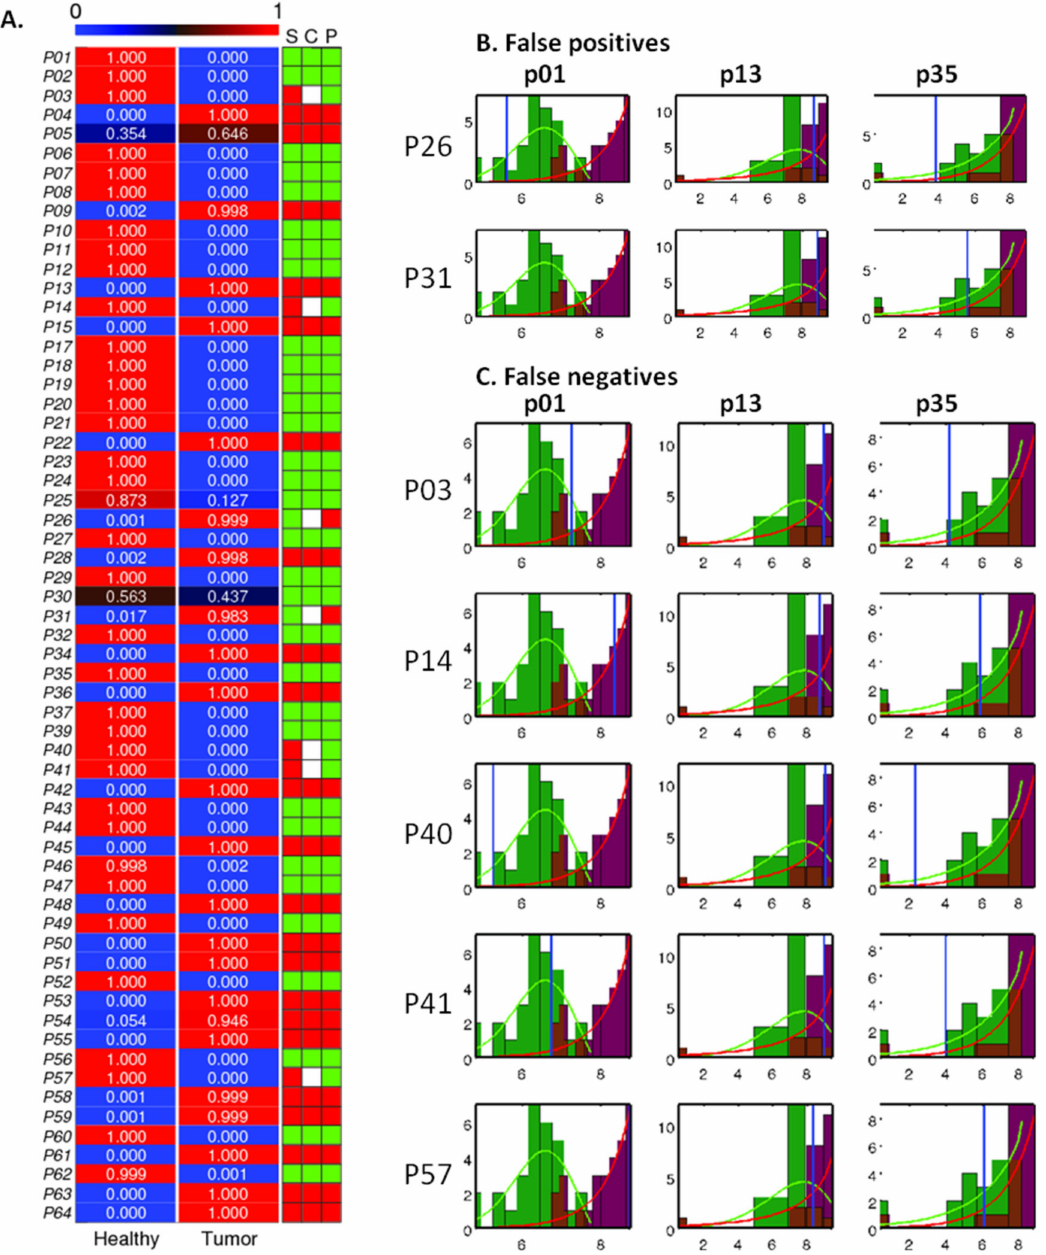
Figure 4. Predictions of the best combination of probes (p1, p13 and p35) on the prospective dataset of 61 patients. ( A ) Heatmap of the probabilities of each sample to be predicted as healthy or tumor. The table to the right marks: S, real status of the sample; P, prediction of the status; and C, the comparison between them. Healthy in green, tumor in red, and mismatch between real status and prediction in white. ( B , C ) Histograms and empirical distribution functions of the probes in healthy (green) and tumor (red) samples of the false positive ( B ) patient samples (P26 and P31) and false negative ( C ) patient samples (P03, P14, P40, P41 and P57). The empirical distribution functions are represented by the continuous lines in green and red for healthy and tumor samples, respectively. The blue vertical line marks the decision boundary of the discriminant analysis. Less overlap between distributions corresponds to better discrimination between healthy and tumor